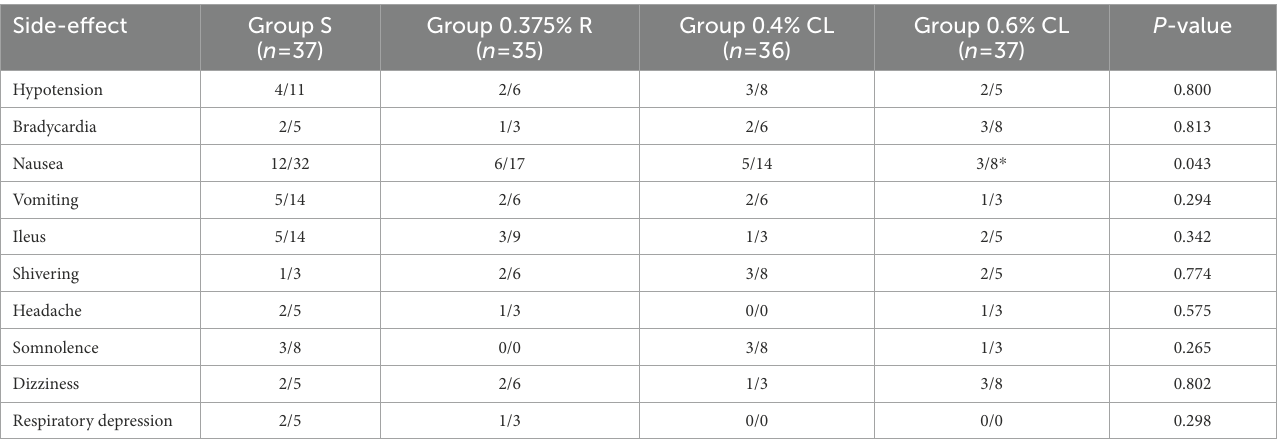
TABLE 4 Postoperative